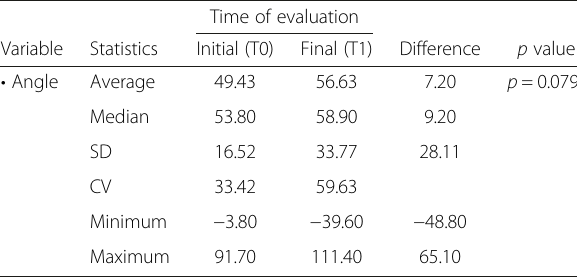
Table 2 Statistical analysis of the steepness changing of the third molars during the evaluation